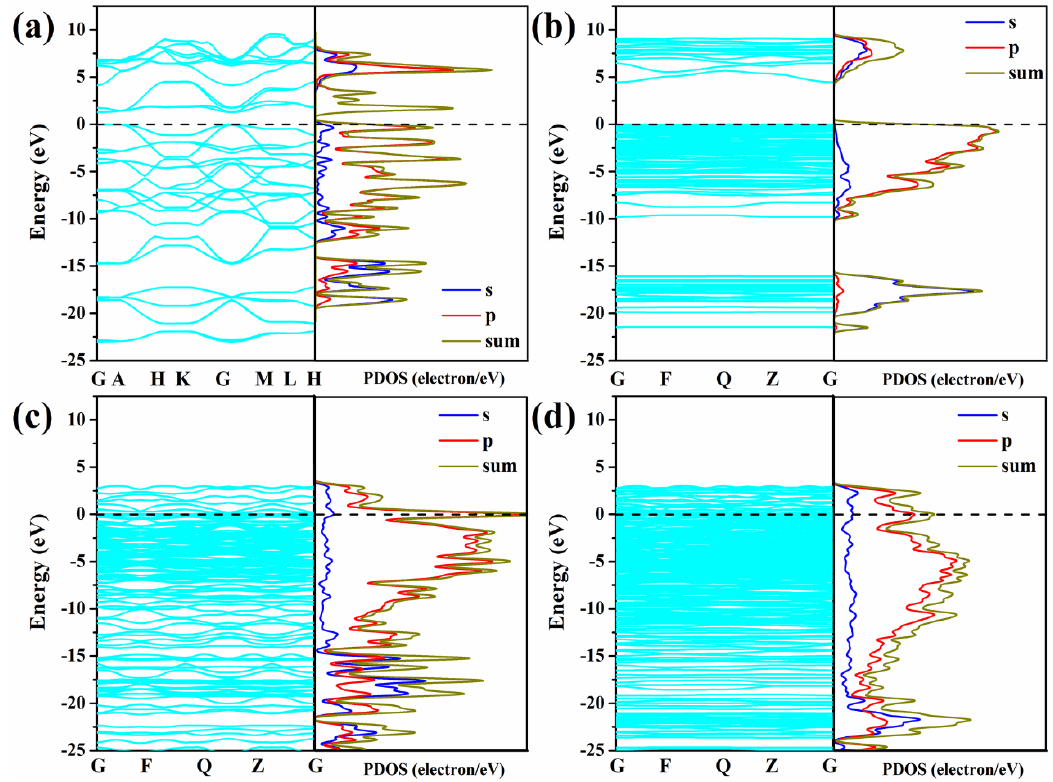
Figure 7. Band structures and partial density of states (PDOS) for ( a ) CN (C 6 N 21 ), ( b ) KA (H 8 Si 4 Al 4 O 18 ), ( c ) CN/KA (2C 6 N 15 -H 8 Si 4 Al 4 O 18 ), and ( d ) m-CN/KA (2C 7 N 14 -H 8 Si 4 Al 4 O 18 ).